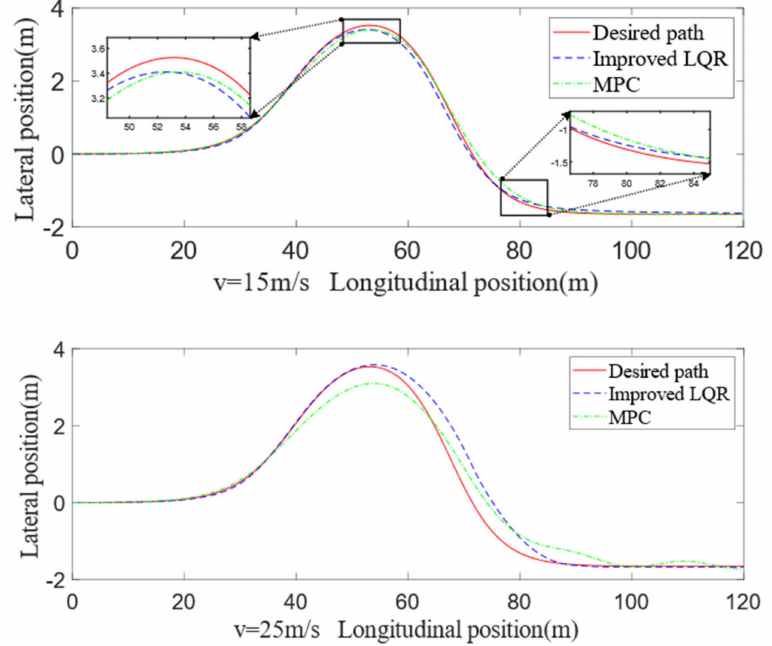
Figure 29. Comparison of the improved LQR and MPC controllers at different